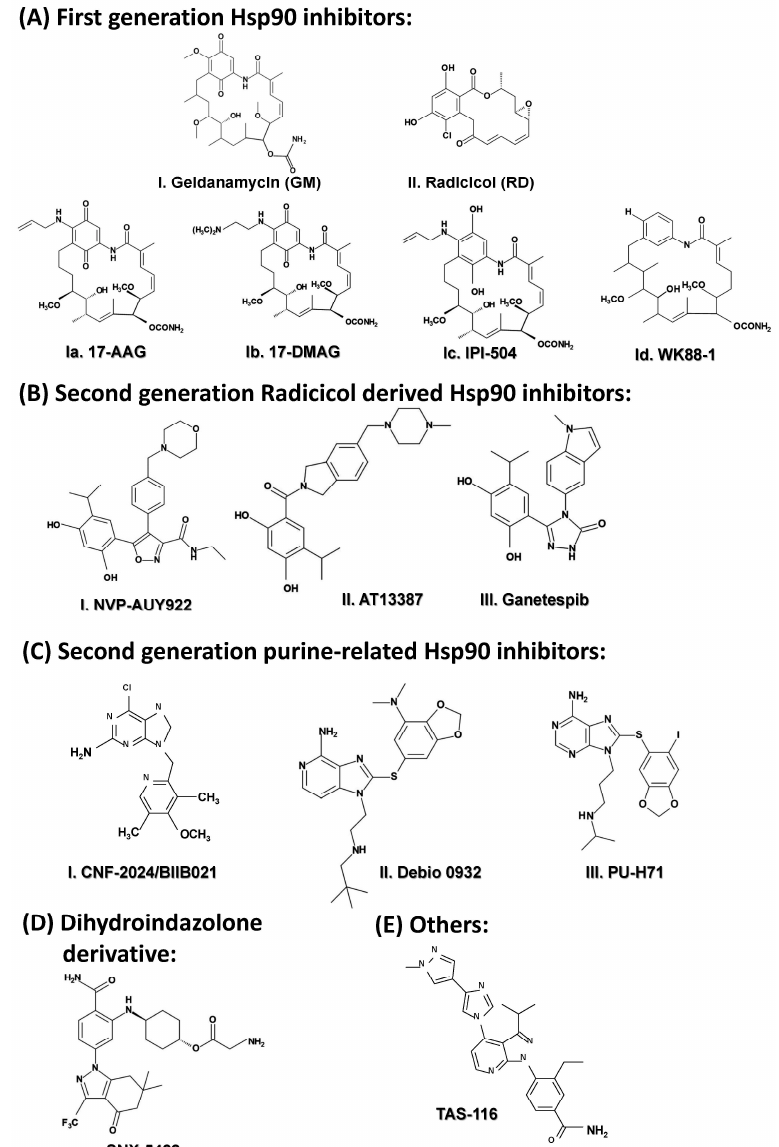
Figure 9. Chemical structures of HSP90 inhibitors. ( A ) The first generation inhibitors were derived from two potent natural inhibitors—( I ) Geldanamycin (GM) and ( II ) Radicicol (RD). To improve the toxic side effects and solubility issues, derivatives of GM were developed; examples include ( Ia ) 17-AAG, ( Ib ) 17-DMAG, ( Ic ) IPI-504, and Id. WK88-1; ( B ) Development of second generation Hsp90 inhibitors began with modifying RD, and the most important examples include—( I ) NVP-AUY922, ( II ) Ganetespib, and ( III ) AT13387. Other important second generation small molecule Hsp90 inhibitors include ( C ) purine related compounds like I. CNF 2024/BIIB021, II. Debio 0932, and III. PU-H71; ( D ) Dihydroindazolone derivative like SNX-5422, and ( E ) the most recent and highly promising TAS-116,3-ethyl-4-[3-(1-methylethyl)-4-[4-(1-methyl-1 H